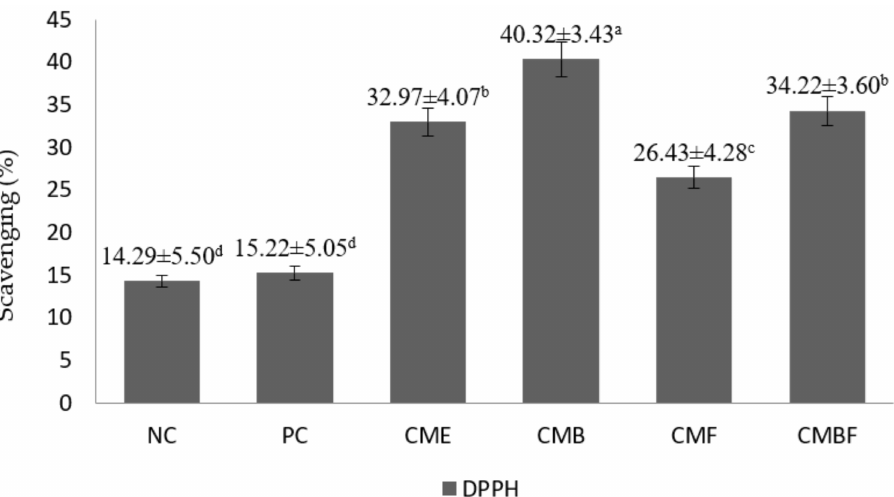
Figure 2. The antioxidative profile of the breast meat of Korean ginseng chicken soup that was hydrolyzed with Cordyceps militaris mushroom extract. NC, negative control; PC, Positive control, Samgyetang that was hydrolyzed with flavorzyme before retorting; CME, Samgyetang that was made with the addition of Cordyceps militaris mushroom extract; CMB, Samgyetang that was hy- drolyzed with Cordyceps militaris mushroom extract: bromelain before retorting; CMF, Samgyetang that was hydrolyzed with Cordyceps militaris mushroom extract: flavorzyme before retorting; CMBF, Samgyetang that was hydrolyzed with Cordyceps militaris mushroom extract: bromelain:flavorzyme before retorting. The values with different superscripts were significantly different ( p <